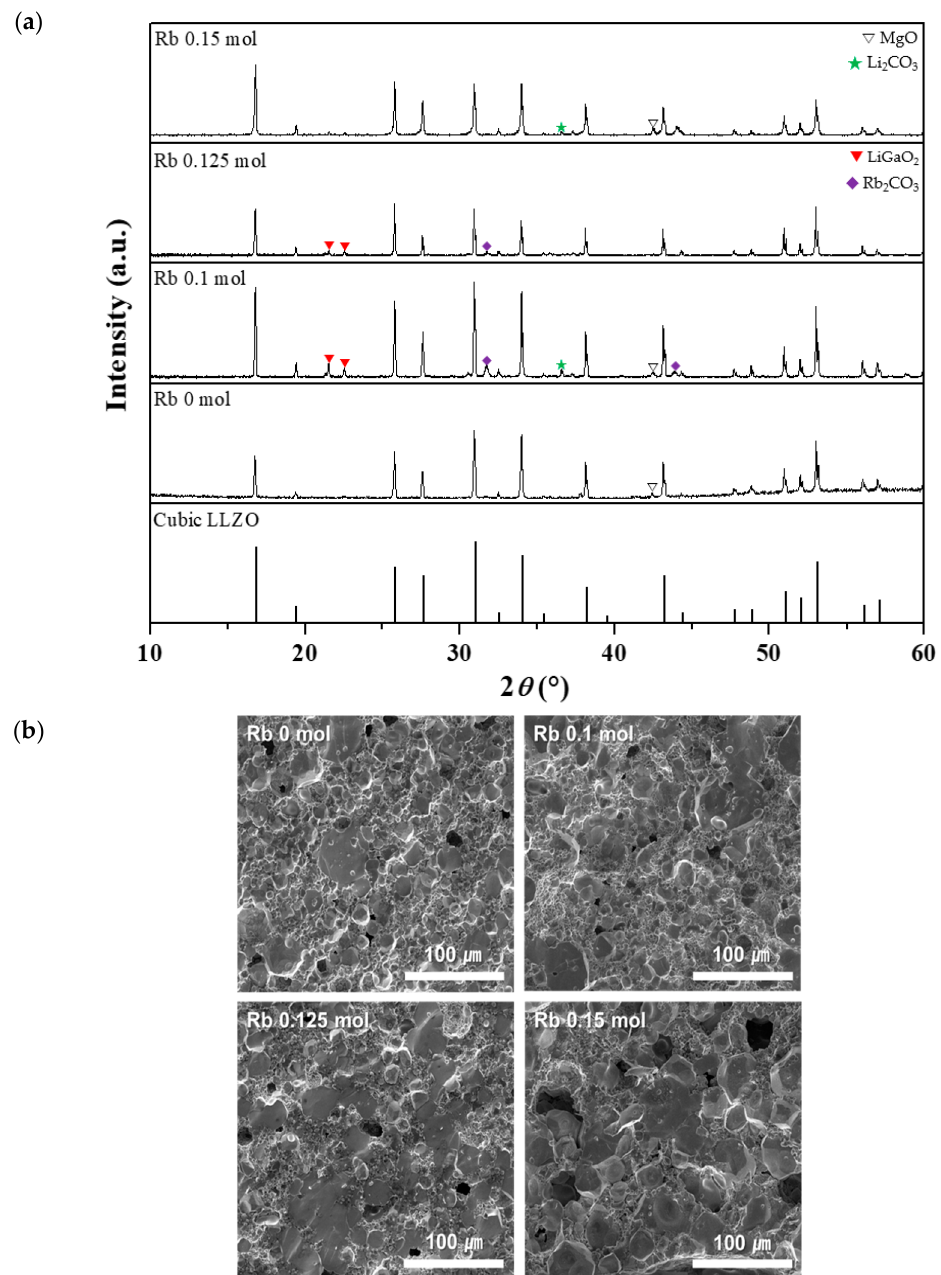
Figure 8. Crystal structure and morphology of tri-doped LLZO ceramics with 0.2 mol Ga, 0.6 mol Nb, and 0–0.15 mol Rb: ( a ) XRD patterns and ( b ) FE-SEM images of fracture surfaces.